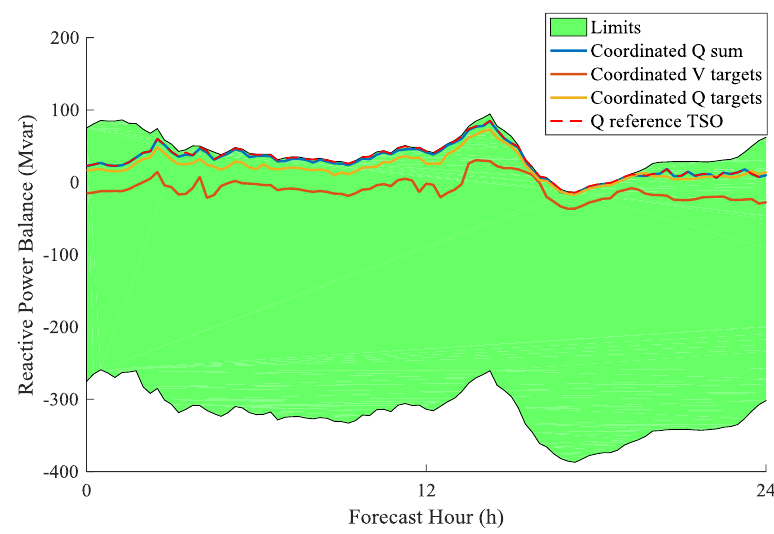
Figure 13. Reactive power exchange between transmission and distribution grid (weekly).